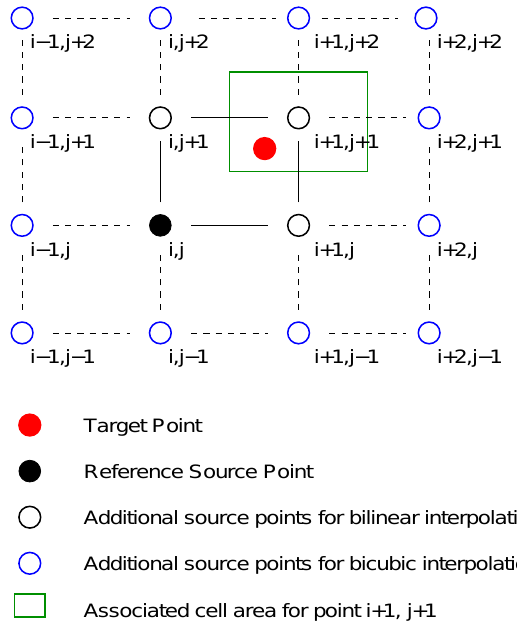
Fig. 3. Building the interpolation star based on the initial